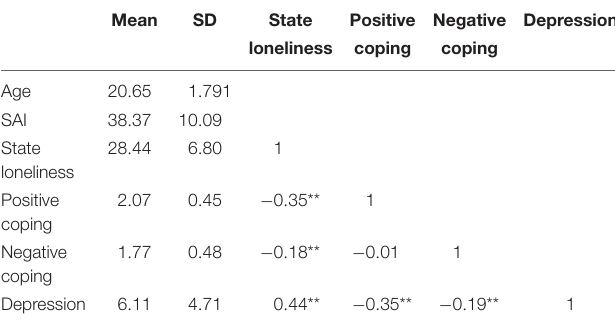
TABLE 1 | Descriptive statistics and correlations among key